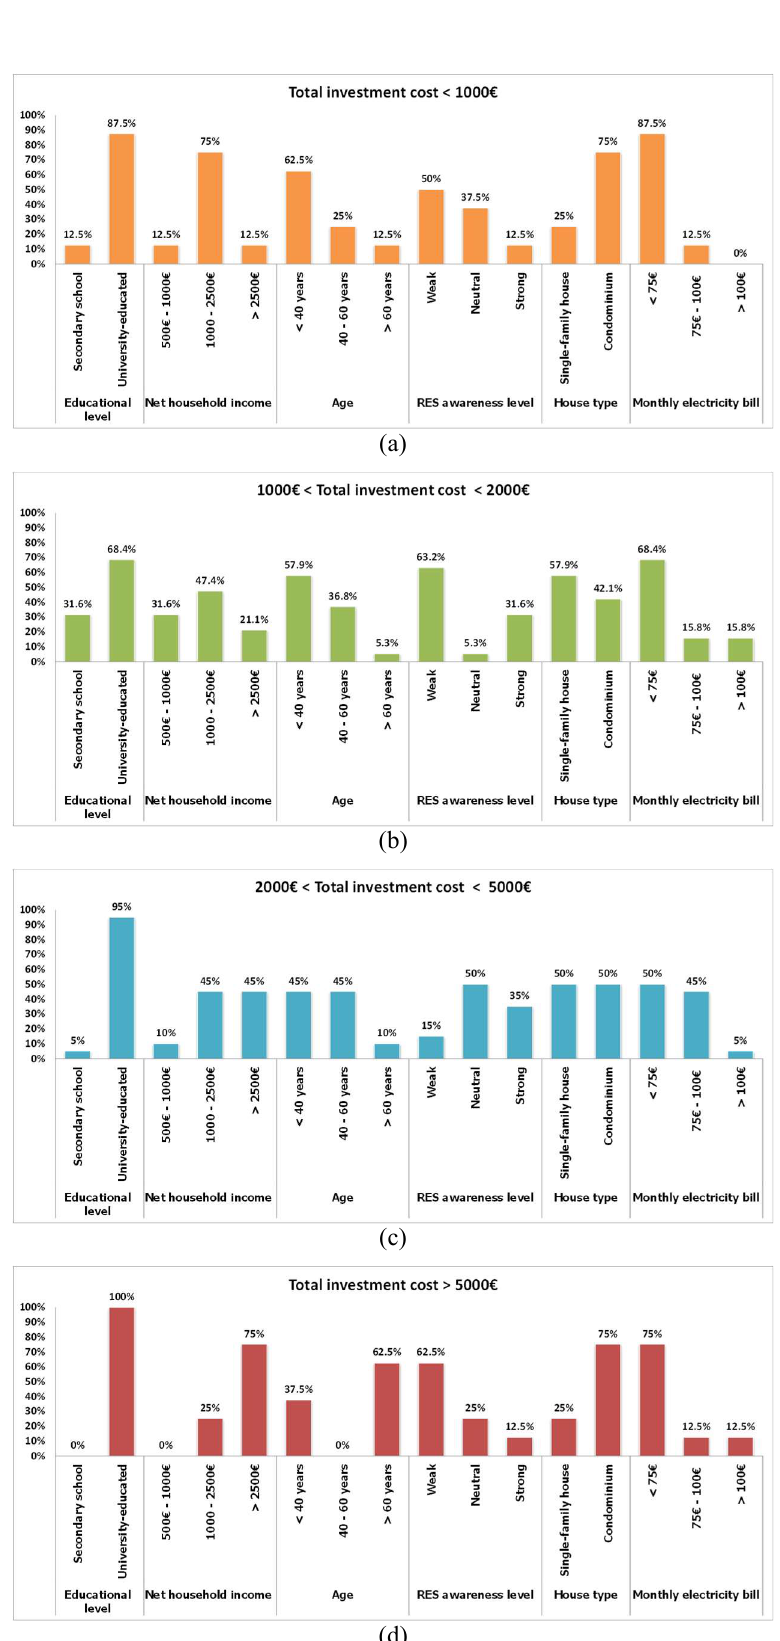
Figure 2 . How much are residential consumers willing to invest in a PV system: (a) investment lower than 1000 €; (b) investment between 1000 € and 2000 €; (c) investment between 2000 € and 5000 €; (d) investment higher than 5000